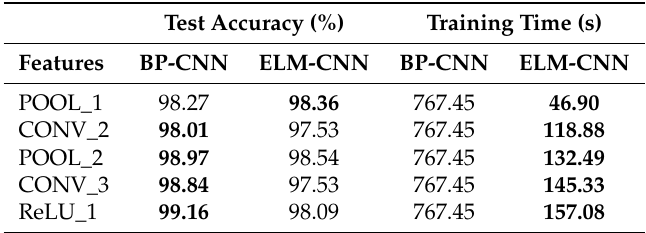
Table 4. Features performance comparison between ELM-CNN and BP-CNN on the MNIST dataset.